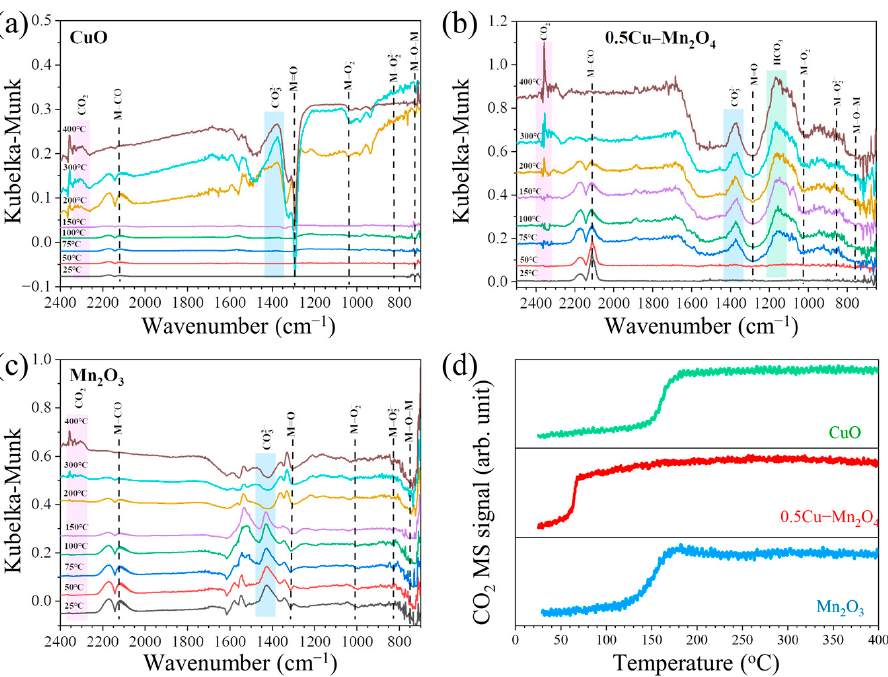
Figure 8. Operando DRIFTS spectra during CO oxidation between 25 and 400 °C on CuO ( a ), 0.5Cu–Mn 2 O 4 ( b ), and Mn 2 O 3 ( c ). ( d ) CO 2 MS signals at various